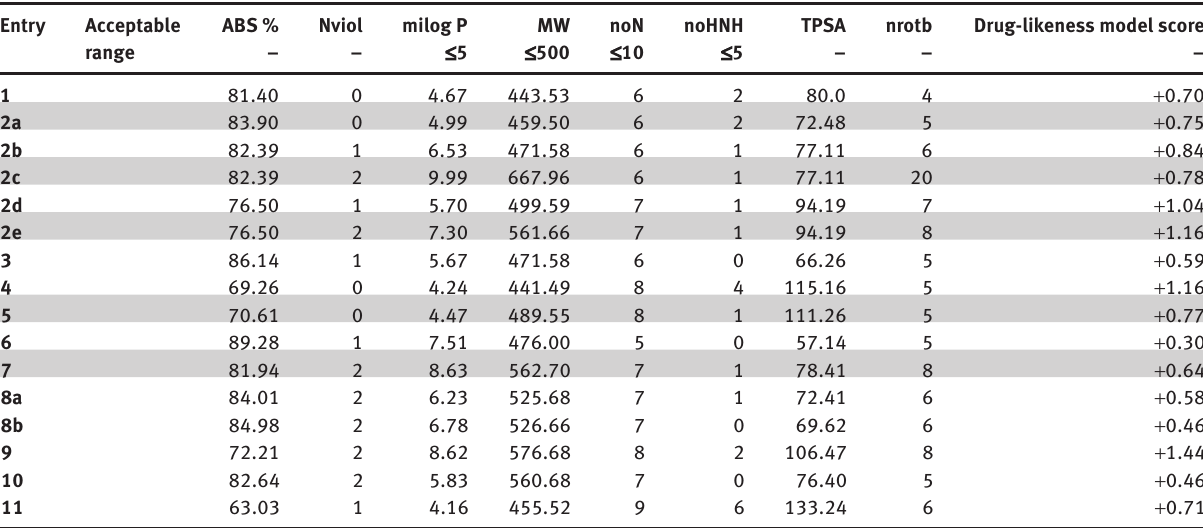
Table 3: The calculated absorption rates (ABS %), polar surface area (PSA), Lipinski parameters a , and drug-likeness model scores of the title compounds 1 – 11